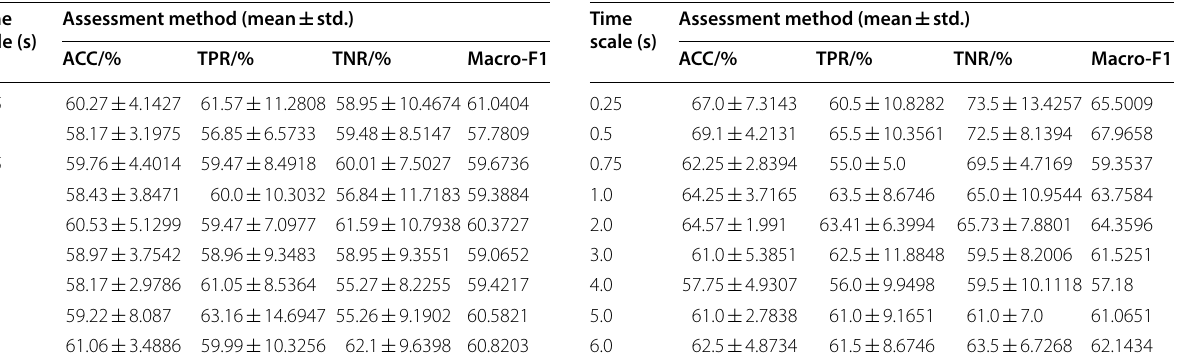
Table 5 The classification results of RT‑ERM with different time scales for θ rhythm under the dimension of emotion arousal